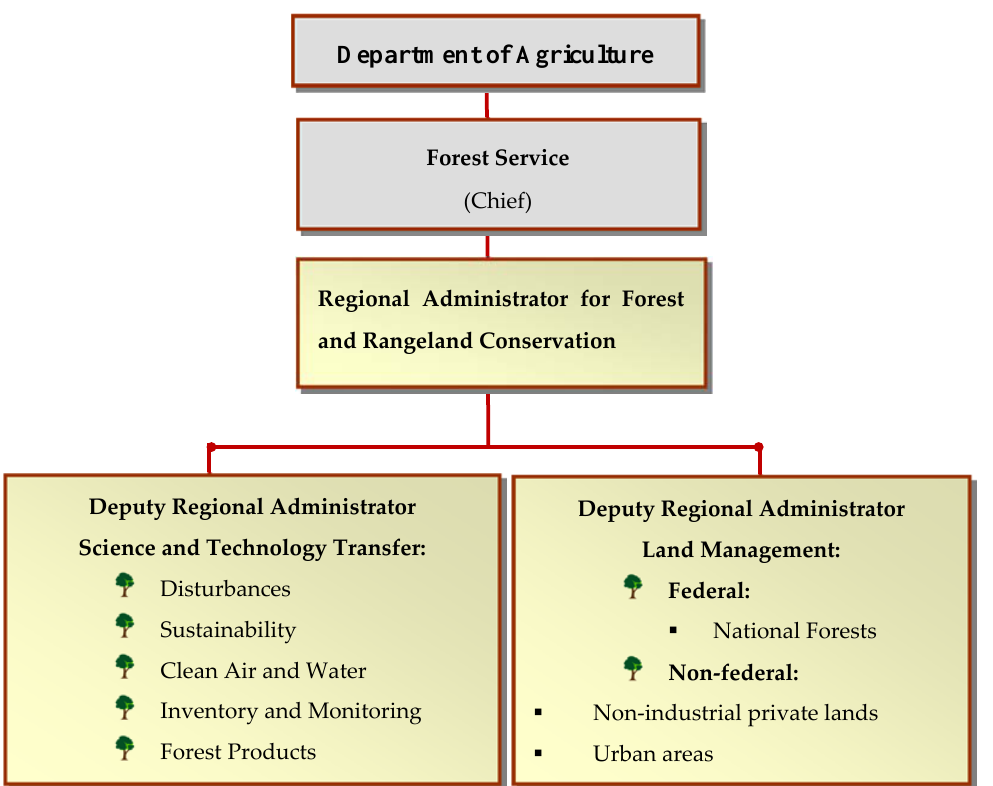
Figure 1. Example Forest Service Field Organization.